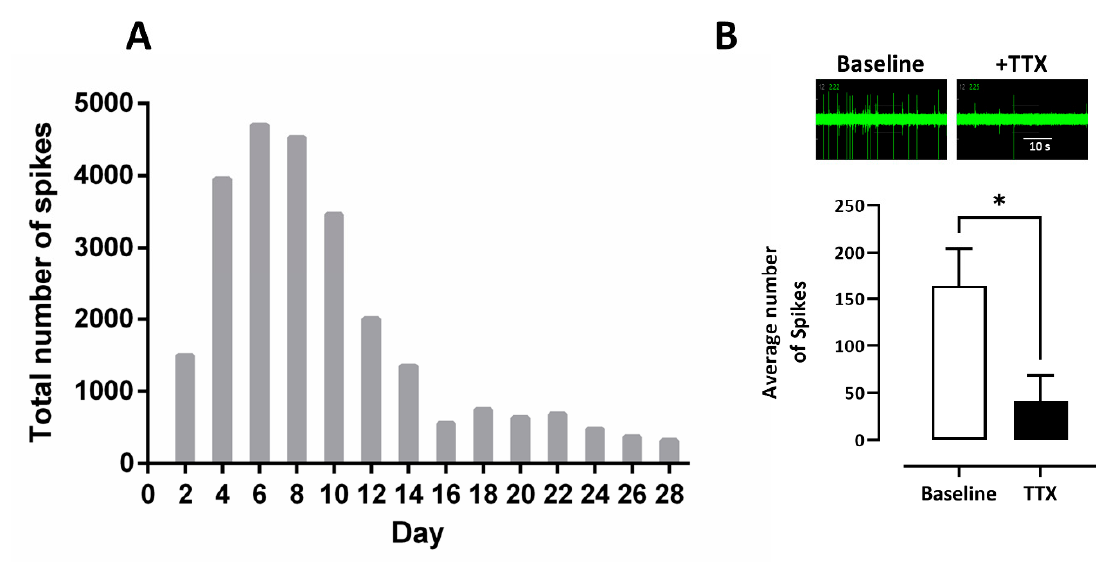
Figure 3. ( A ) a histogram summary of the total number of spikes recorded from iCell neurons in a 10-min recording period, every two days over 28 days in vitro. ( B ) a MEA spike trace before (baseline) and in the presence of tetrodotoxin (TTX, 0.1 µ M) with a histogram showing that it significantly (* p ≤ 0.05) reduced the number of spikes recorded over a 10 min period. The bars and lines represent the mean ± SEM ( n = 4).